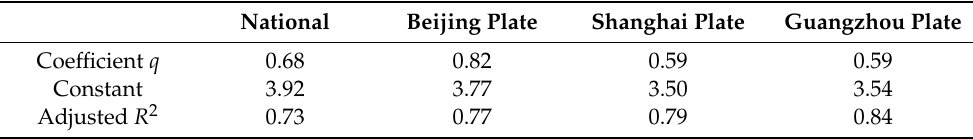
Table 5. City rank-size distribution by economic plate. National Beijing Plate Shanghai Plate Guangzhou Plate Coefficient